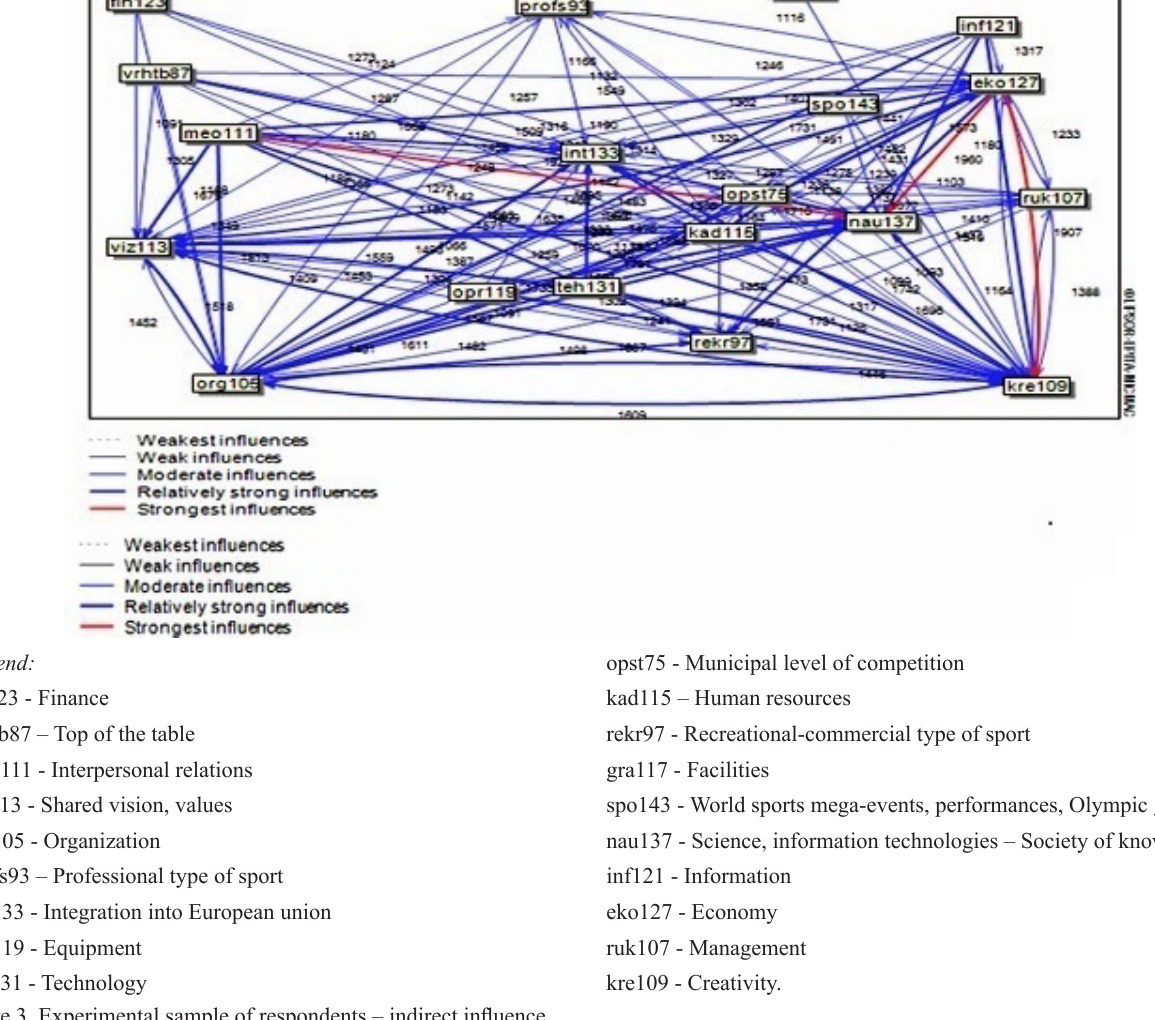
Figure 3. Experimental sample of respondents – indirect influence.